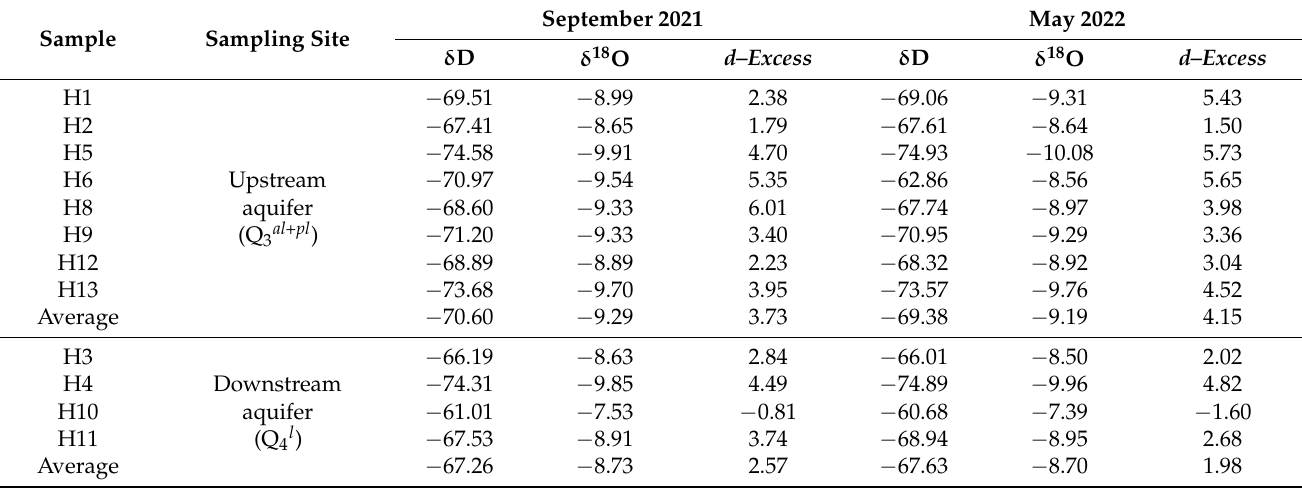
Table 5. Statistics of δ D, δ 18 O and d–excess in different seasons (Unit: ‰).